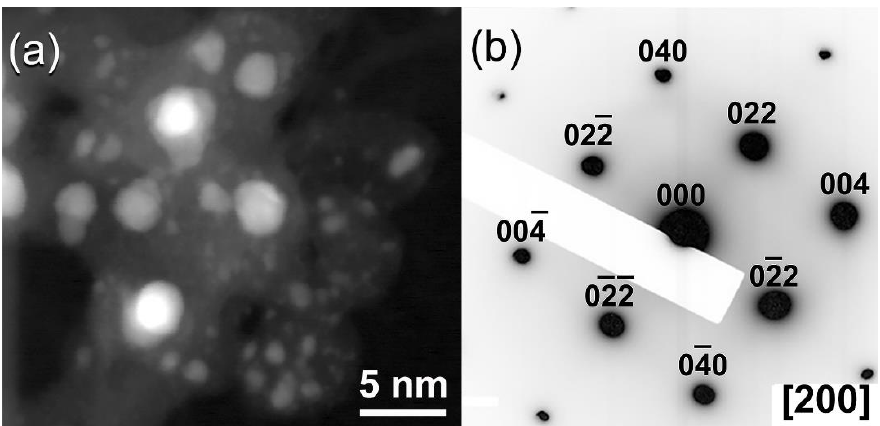
Figure 9. ( a ) FE-HRTEM image and ( b ) corresponding NBDP of the sample obtained after 16 h of milling.